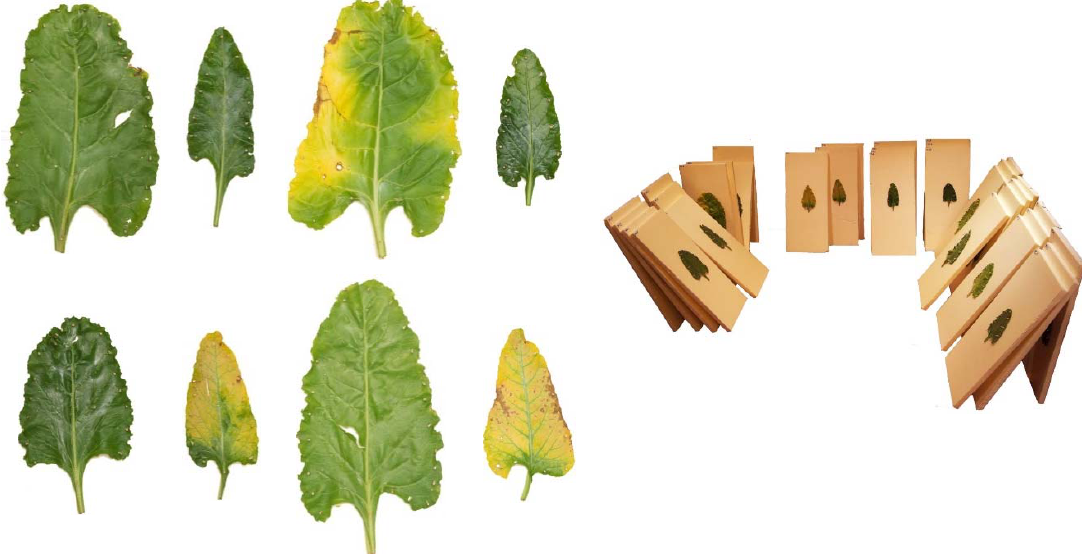
Figure 1. ( Left ) Some of the 35 leaves used in the experiment, with sizes in the 15–25 cm range. The leaves were selected to provide a representative sample of the leaf size and coloring in commercial plots during the harvest season. ( Right ) Leaves vertically arranged in individual polyurethane sheets for the photo